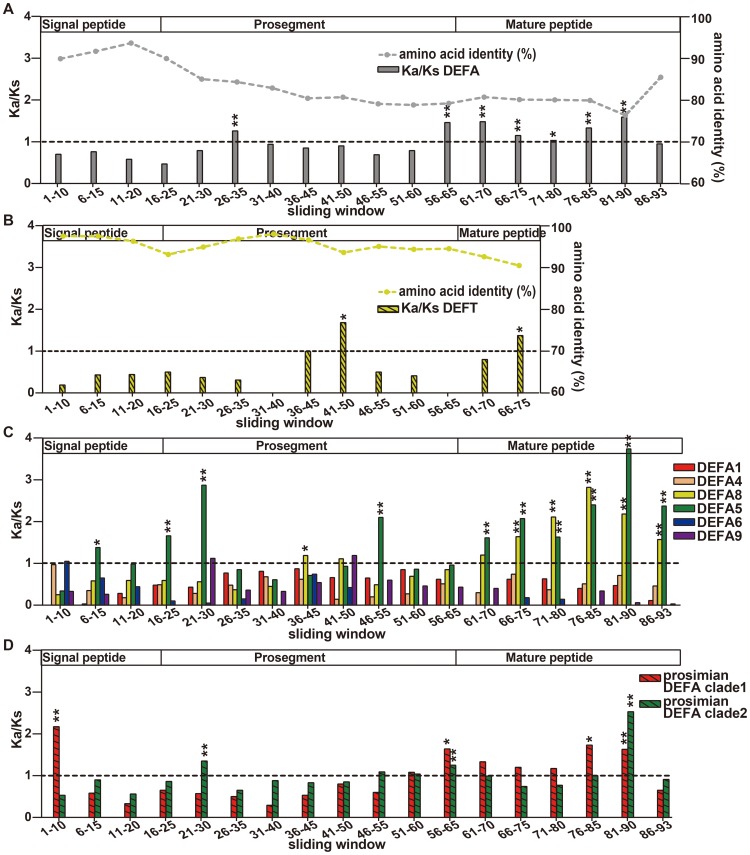
Sliding window analyses of the Ka/Ks for all DEFA, DEFT and separate DEFA clusters.A: Sliding window analysis of the amino acid identity and Ka/Ks for all DEFA. The sequence conservation decreases from the signal peptide and prosegment to the mature peptide. The selection pressures acting on different windows are different as indicated by the Ka/Ks ratios. Fragment 26–35 in the prosegment region, fragment 56–65 in the cleavage region and most fragments in the mature peptide are under positive selection (Ka/Ks>1). The significance of Ka/Ks>1 is tested by a bootstrap method and is indicated by * (P<0.05) or ** (P<0.01). B: Sliding window analysis of the amino acid identity and Ka/Ks for DEFT. The sequence conservation also decreases from the signal peptide and prosegment to the mature peptide. The selection pressure on different regions is also variable. Compared to the same region of all DEFA and that of DEFA8, fragment 41–50 in the prosegment of DEFT is under strong positive selection. C: Sliding window analysis of Ka/Ks for each simian DEFA cluster. Only the DEFA5 and DEFA8 clusters contain fragments that are under positive selection. D: Sliding window analysis of Ka/Ks for the two prosimian clades. The fragment 56–65 in the cleavage region is also under positive selection for both prosimian clades, consistent with that of all DEFA.